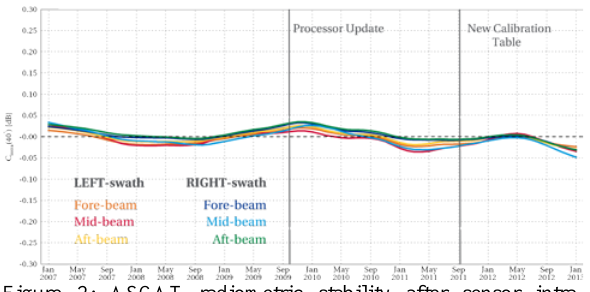
Figure 2: ASCAT radiometric stability after sensor intra-